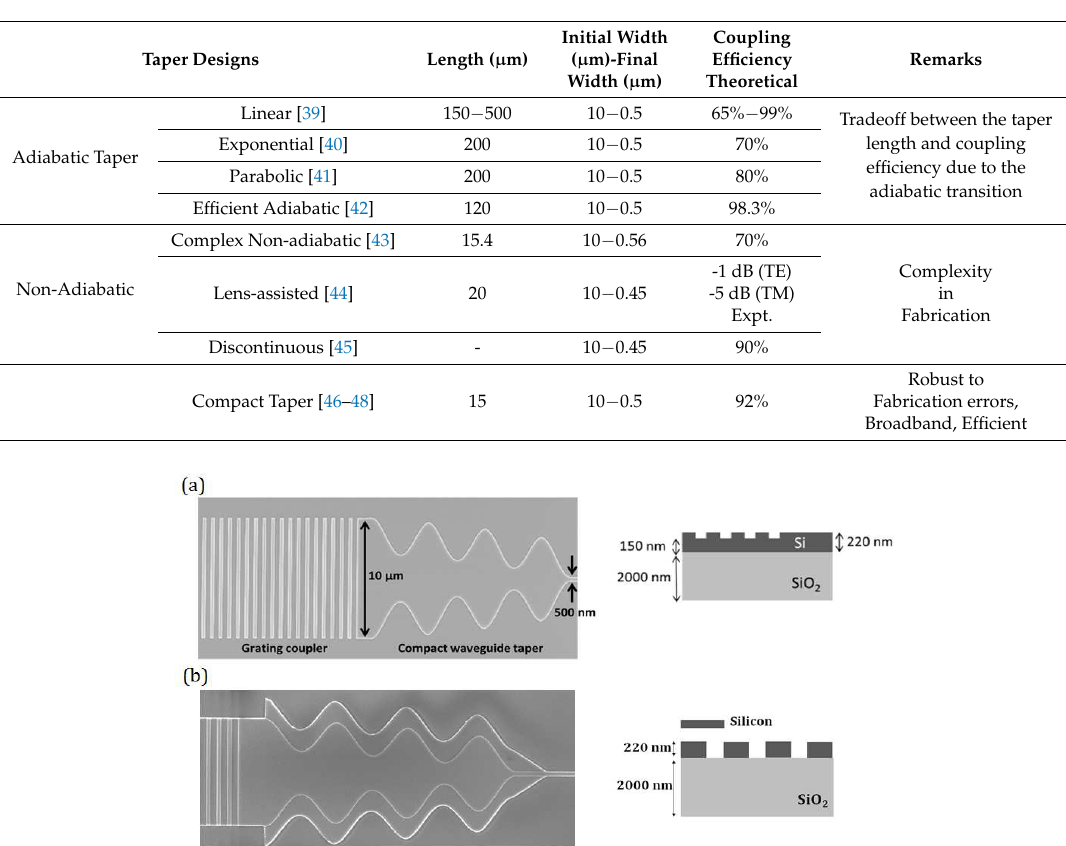
Table 2. Various Adiabatic and Non-Adiabatic Tapers on SOI proposed in literature.